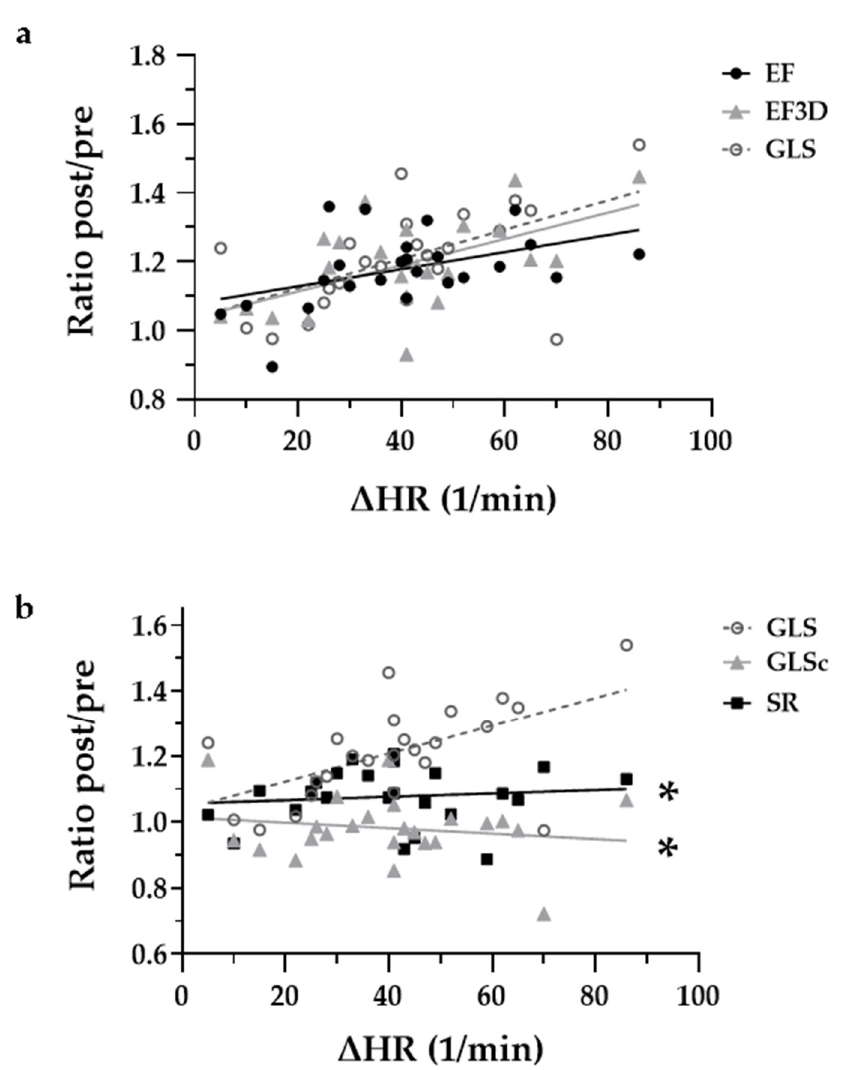
Figure 5. Influence of HR on systolic LV function (given as ratio post/pre ECV). Scatter plotting ∆ HR vs. change of measures for systolic LV function calculated as ratios post/pre for EF, EF3D, GLS ( a ), GLS, GLSc and SR ( b ). Slopes in a simple linear regression for EF, EF3D and GLS significantly differ from zero, but are not significantly different ( a ). Slopes for GLSc and SR do not deviate significantly from zero and both differ significantly from GLS ( b ). Δ HR, difference of heart rate before and after electrical cardioversion; LV, left ventricular; EF, ejection fraction measured via 2D; EF3D, ejection fraction measured via 3D; GLS, global longitudinal strain; GLSc, global longitudinal strain corrected for RR interval; SR, strain rate. * indicates a p -value of < 0.05 vs. slope GLS.